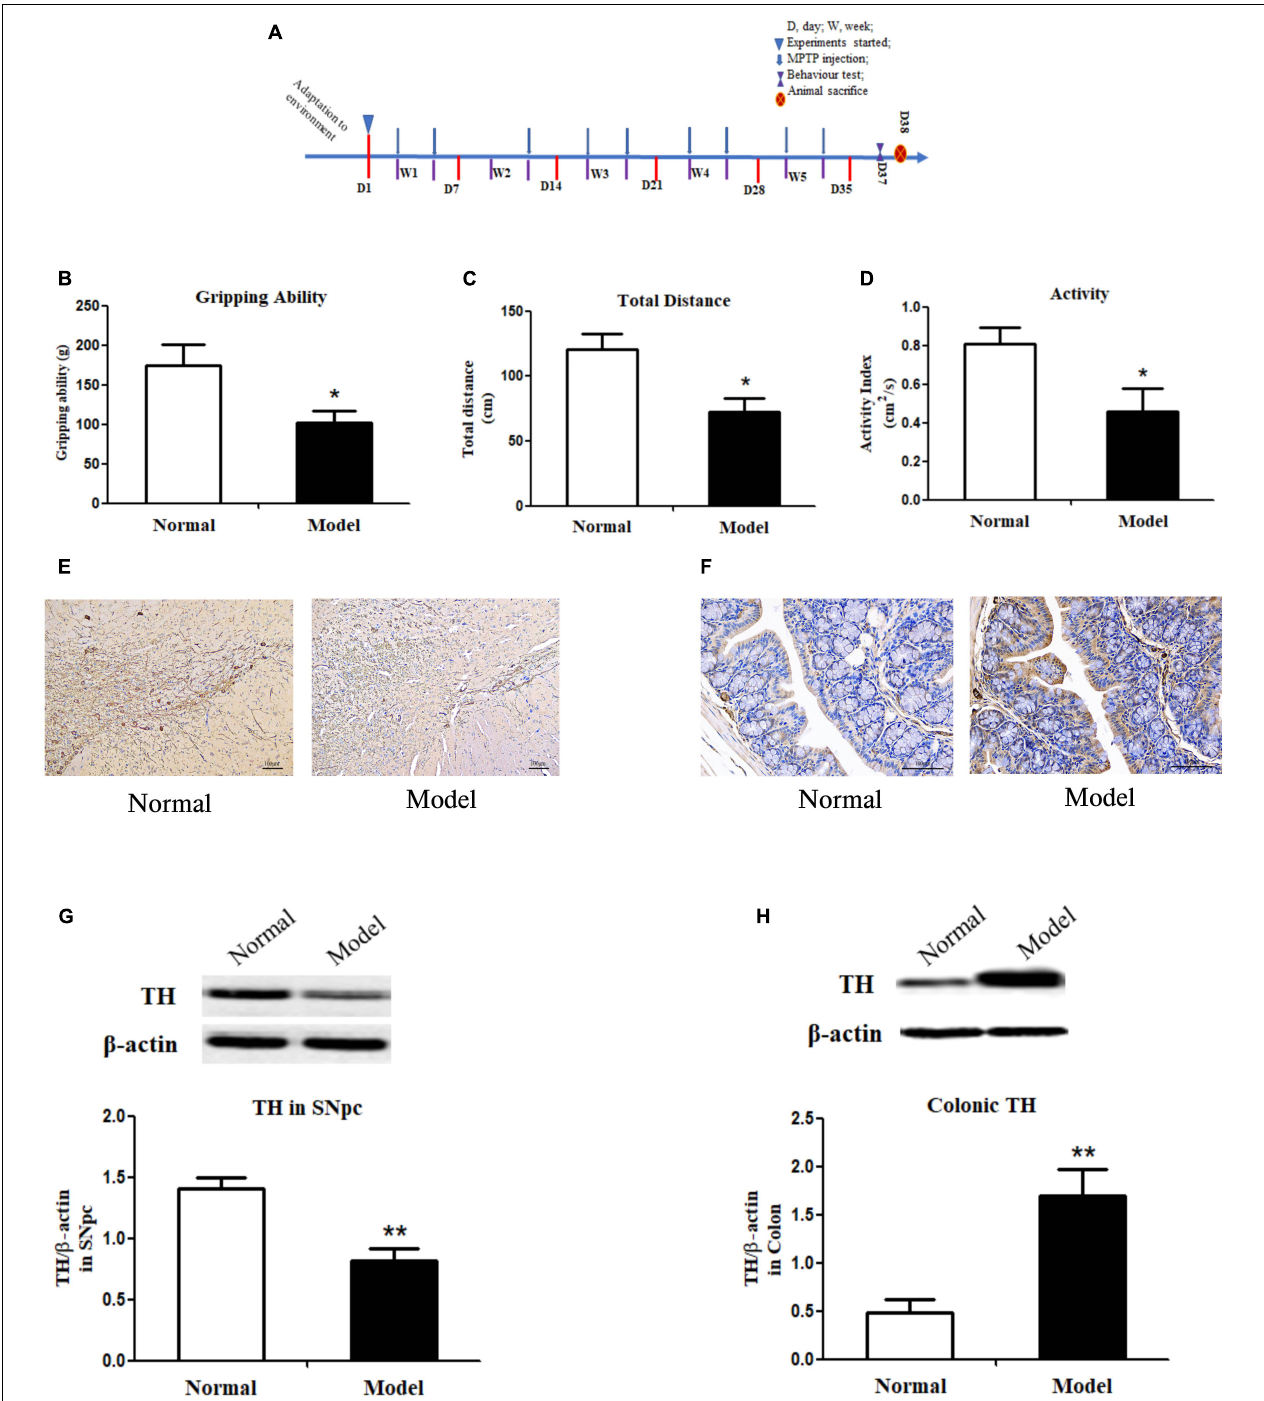
FIGURE 1 | Experimental timeline, behavior tests, immunochemistry staining of tyrosine hydroxylase and its protein expressions in both the substantia nigra pars compacta and colon of mice. (A) Timeline of animal experiments. (B) Grip strength test of mice indicated by gripping ability (g); Open field test of mice indicated by total distance traveled (cm) (C) and activity index (cm 2 /s) (D) within a 5-min period ( n = 8). Representative IHC staining of TH in sections of the SNpc (E) and the colon (F) in normal and PD mice. TH protein expressions in the SNpc (G) and the colon (H) of normal and PD model mice (One representative band for TH and endogenous β -actin from each group; and the following bar chart ( n = 6–8) shows the ratio of TH/ β -actin in the SNpc and colon of mice). Values are expressed as mean ± SEM. * p < 0.05, ** p < 0.01 vs. Model group. IHC, immunochemistry; TH, tyrosine hydroxylase; SNpc, substantia nigra pars compacta; PD, Parkinson’s